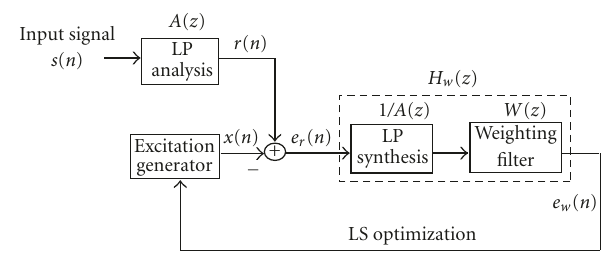
Figure 2: Analysis-by-synthesis